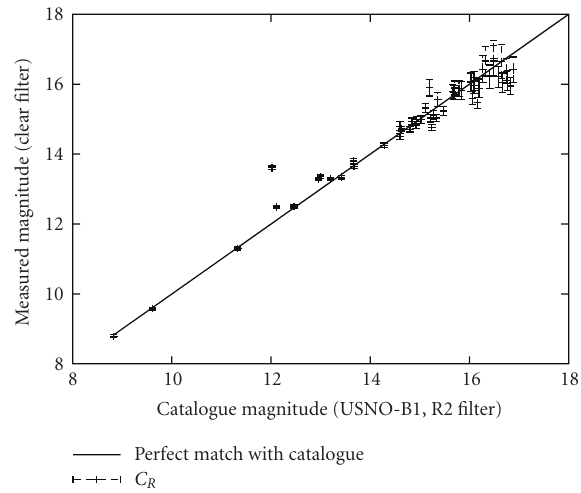
Figure 2: Measured magnitudes of reference stars versus catalogue magnitudes for a Watcher test